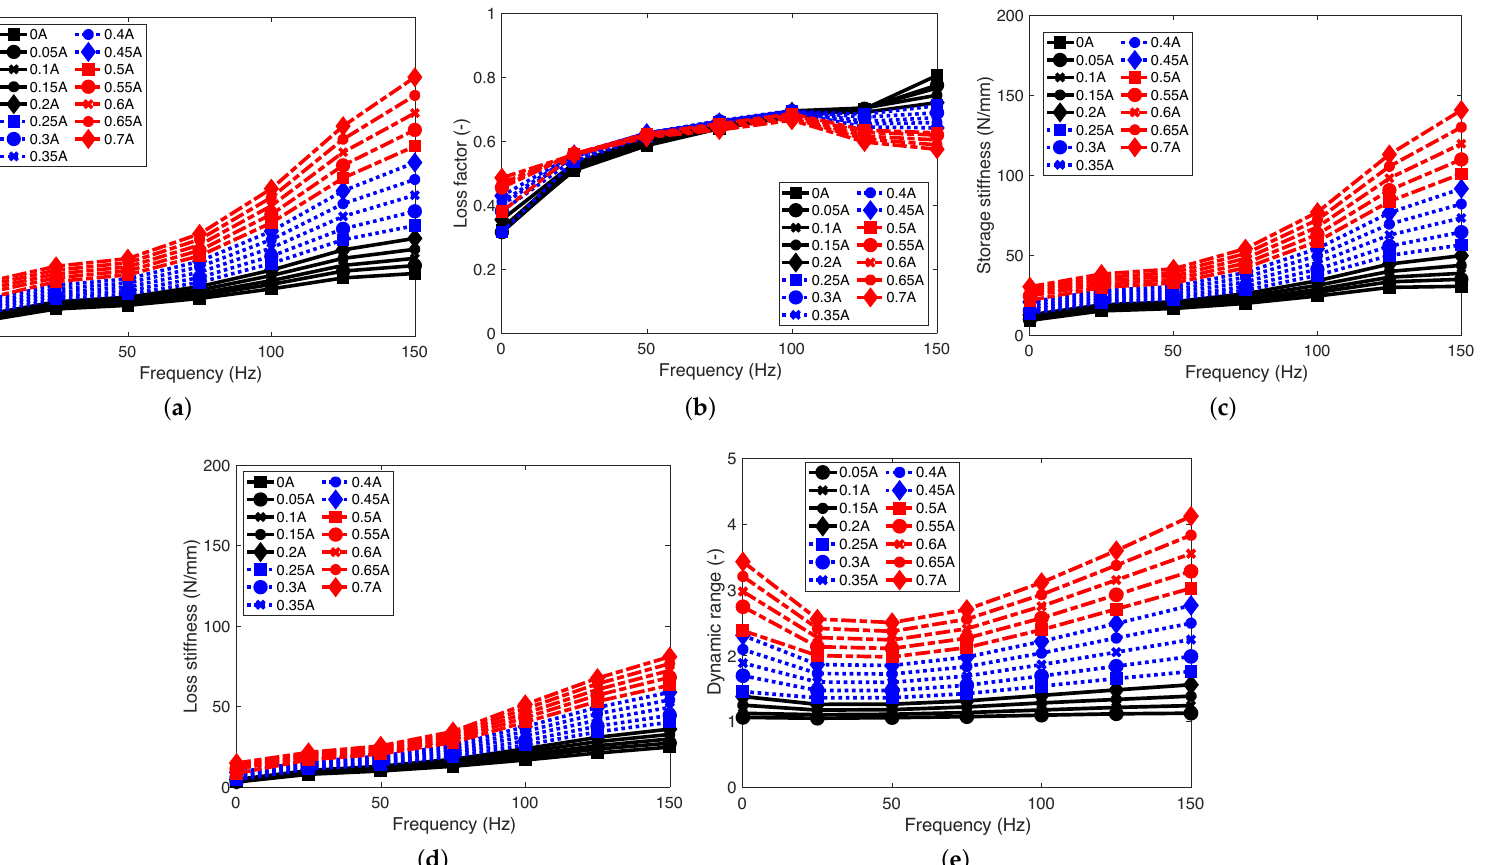
Figure 8. Complex stiffness analysis of the MRE-DVA in the frequency domain (3 mm pad thickness): ( a ) dynamic stiffness, K d ( ω , i ) , ( b ) loss factor, η , ( c ) storage